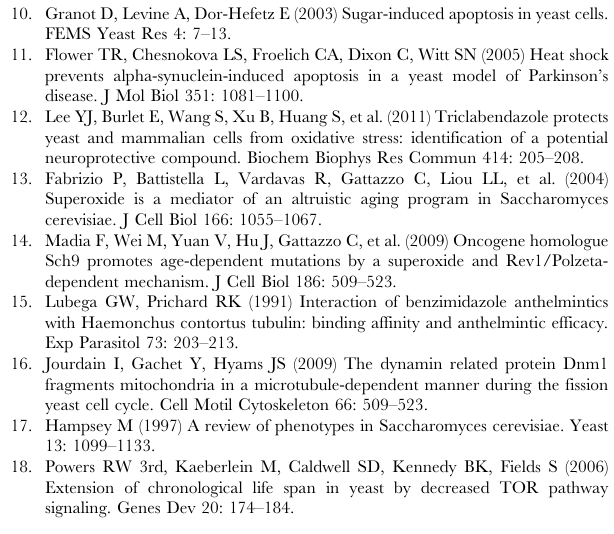
Figure S3 Bcy1 is required for triclabendazole biolog- ical activity. (A) Doubling time. Cells (wild-type, WT, or bcy1 D / bcy1 D ) were inoculated in SC-glucose medium with the indicated